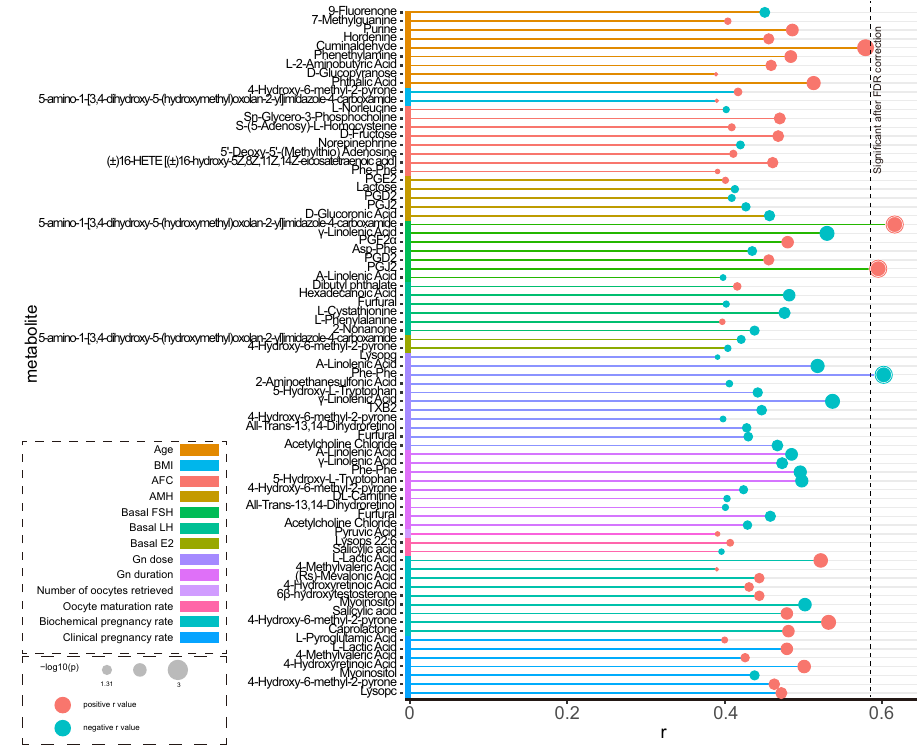
Fig. 5 Signi fi cant spearman correlation between the metabolite ratios and clinical epidemiological information in follicular fl uid samples. The metabolite ratio = metabolite level in small follicles/metabolite level in large follicles. AFC antral follicle count, FSH follicle-stimulating hormone, AMH anti- mullerian